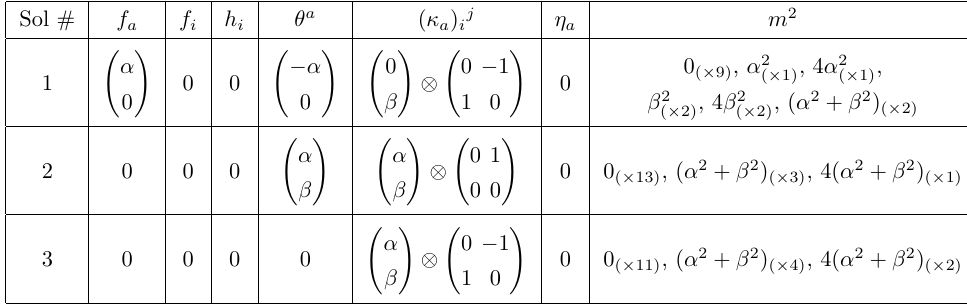
Table 21 . Critical points of the scalar potential induced by the compacti(cid:12)cation of IIB with O7/D7. In this case, we obtain three 2-parameter families of solutions. When evaluated at the critical points, the scalar potential vanishes, thus giving rise to a Mkw